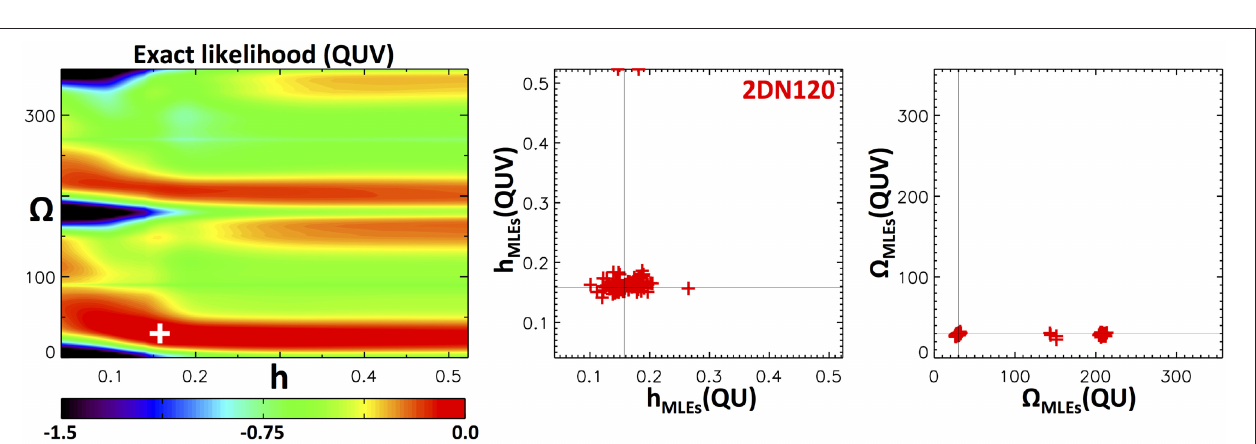
FIGURE 9 | Effect of using circular polarization on the log-likelihood function of Figure